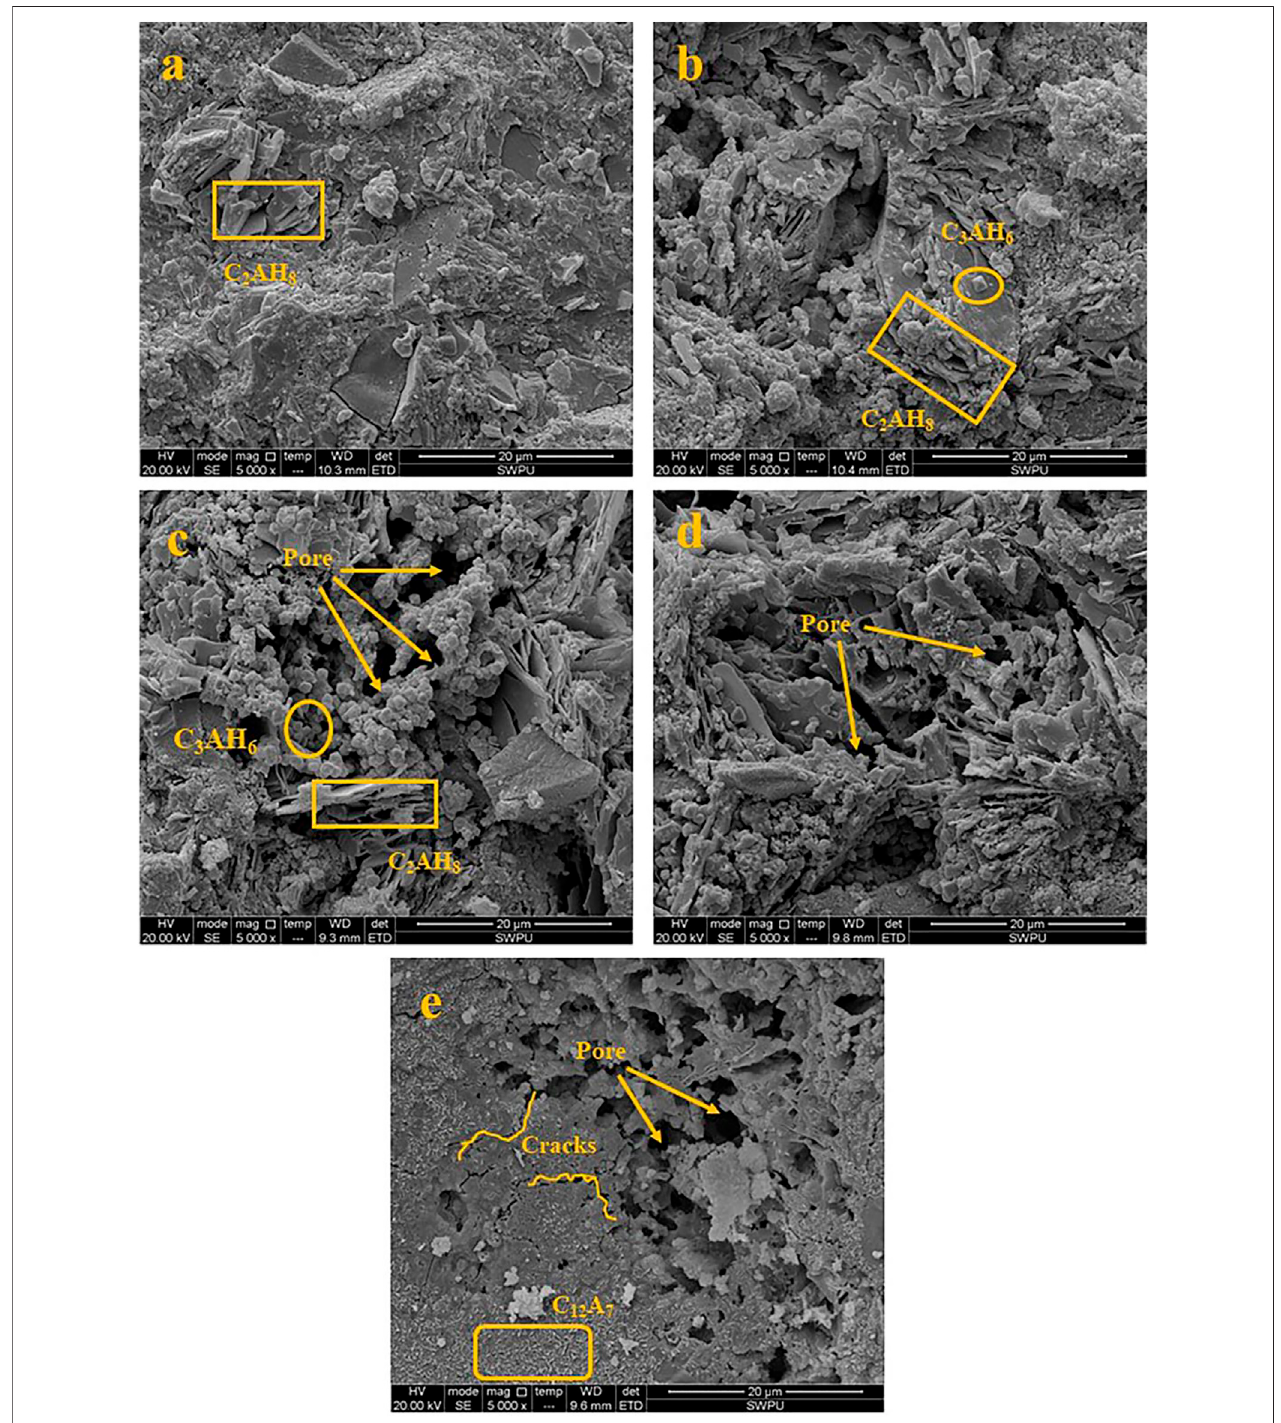
FIGURE 13 | Micro morphology of the C1 cement paste cured at different temperatures ( a : 50 ° C; b : 300 ° C; c : 400 ° C; d : 500 ° C; e : 600 ° C).